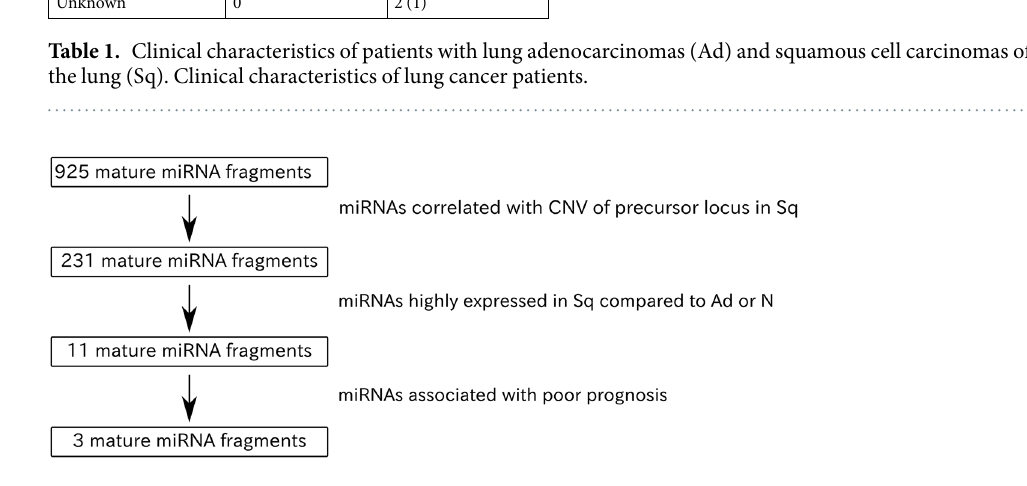
Figure 1. Flow diagram showing the miRNA selection process used in this